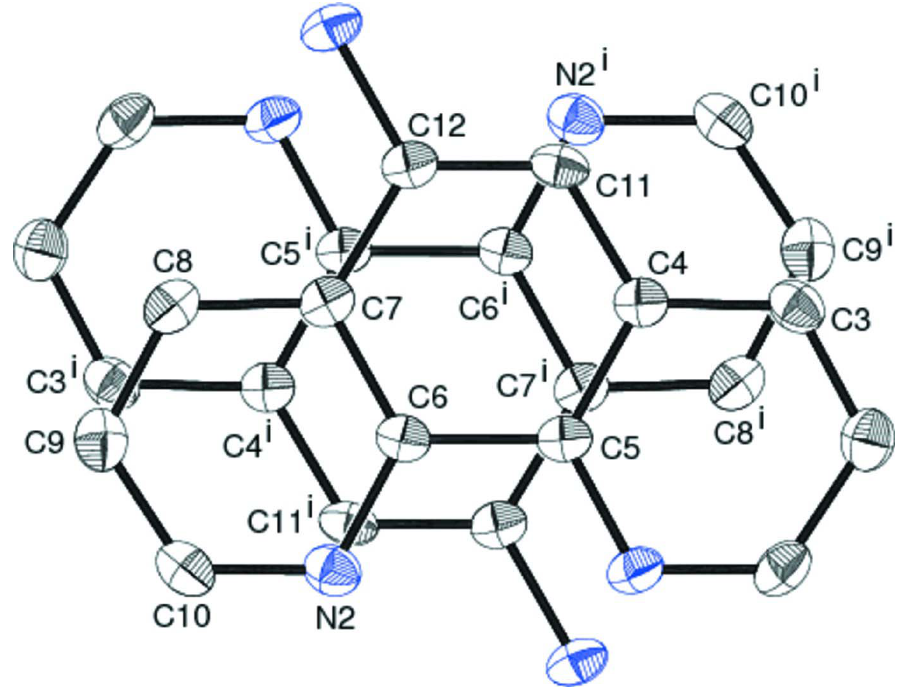
Figure 3 View showing the manner in whch the phen moieties of two symmetry related molecules are stacked, showing a view perpendicular to the planes stacked to each other. Only the labeled atoms are involved in the mean-plane calculations carried out to determine the interplanar separation between the two planes stacked with two different interactions within a one dimensional column. H atoms have been omitted for clarity. [Symmetry codes: (i) 1 - x , 1 - y , 1 - z ; (ii) 2 - x , 1 - y , 1 - z